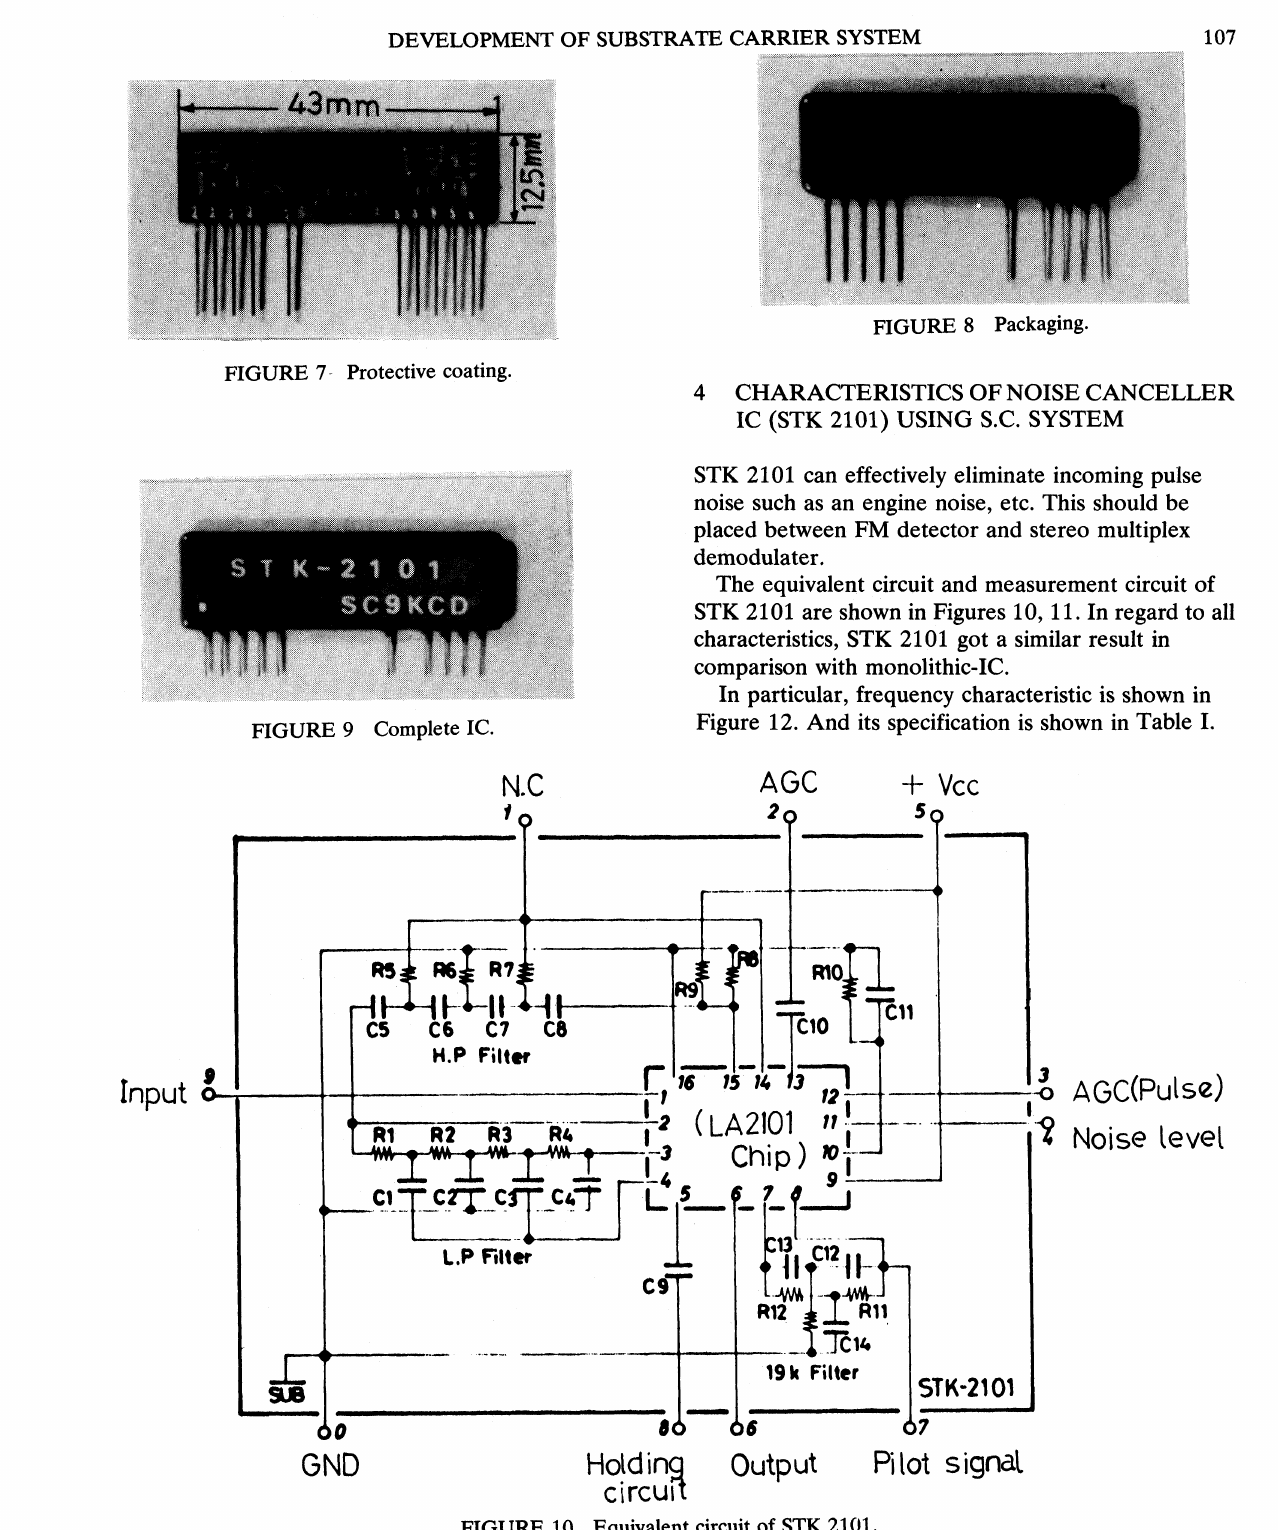
FIGURE 10 Equivalent circuit of STK